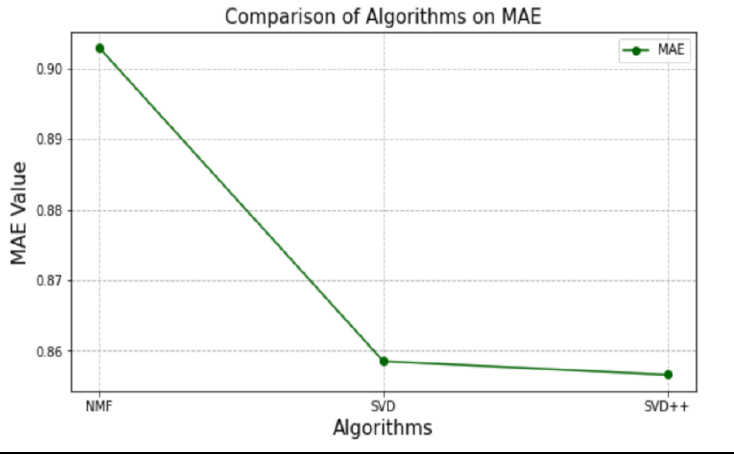
Figure 3. Method comparison based on the MAE metric.